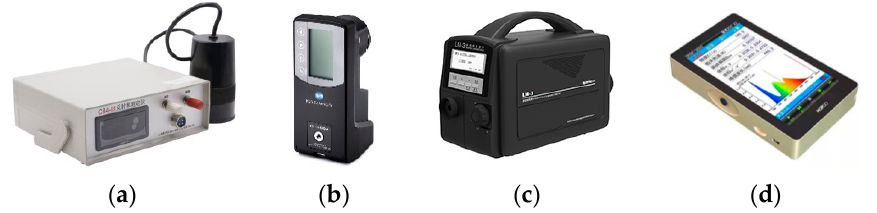
Figure 4. Testing devices for lighting environment parameters in tunnel. ( a ) Reflectance tester, ( b ) illuminance meter, ( c ) luminance meter, ( d ) multifunctional spectrometer.